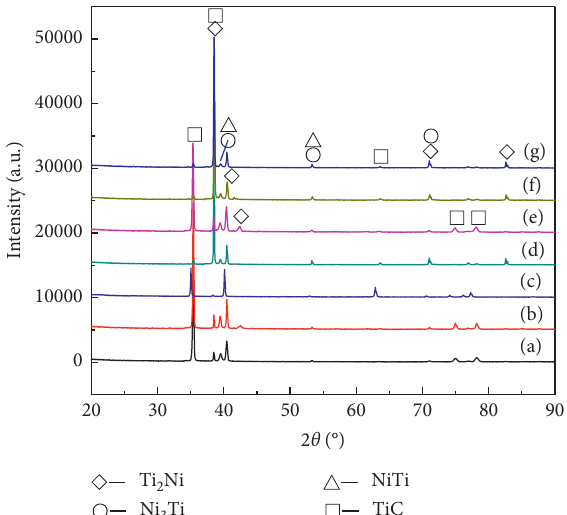
Figure 1: X-ray diffraction spectrum of laser-cladding coatings with different CeO and (g) 6%.